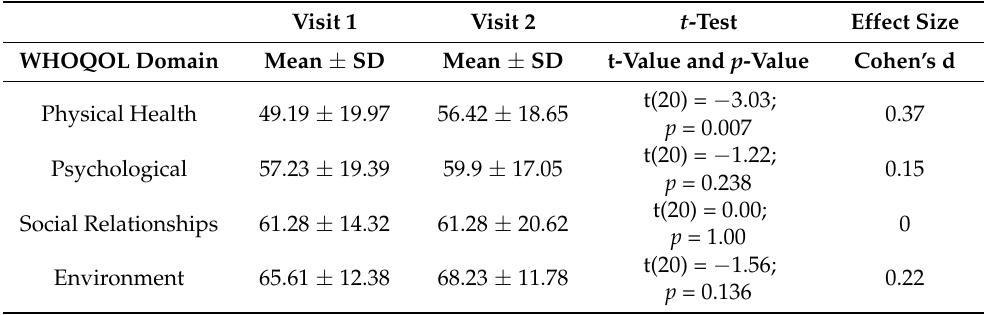
Table 2. Descriptive statistics: means and standard deviations for the quality of life scores (WHOQOL- BREF domains) from visit 1 and visit 2. Visit 1 Visit 2 t -Test Effect Size